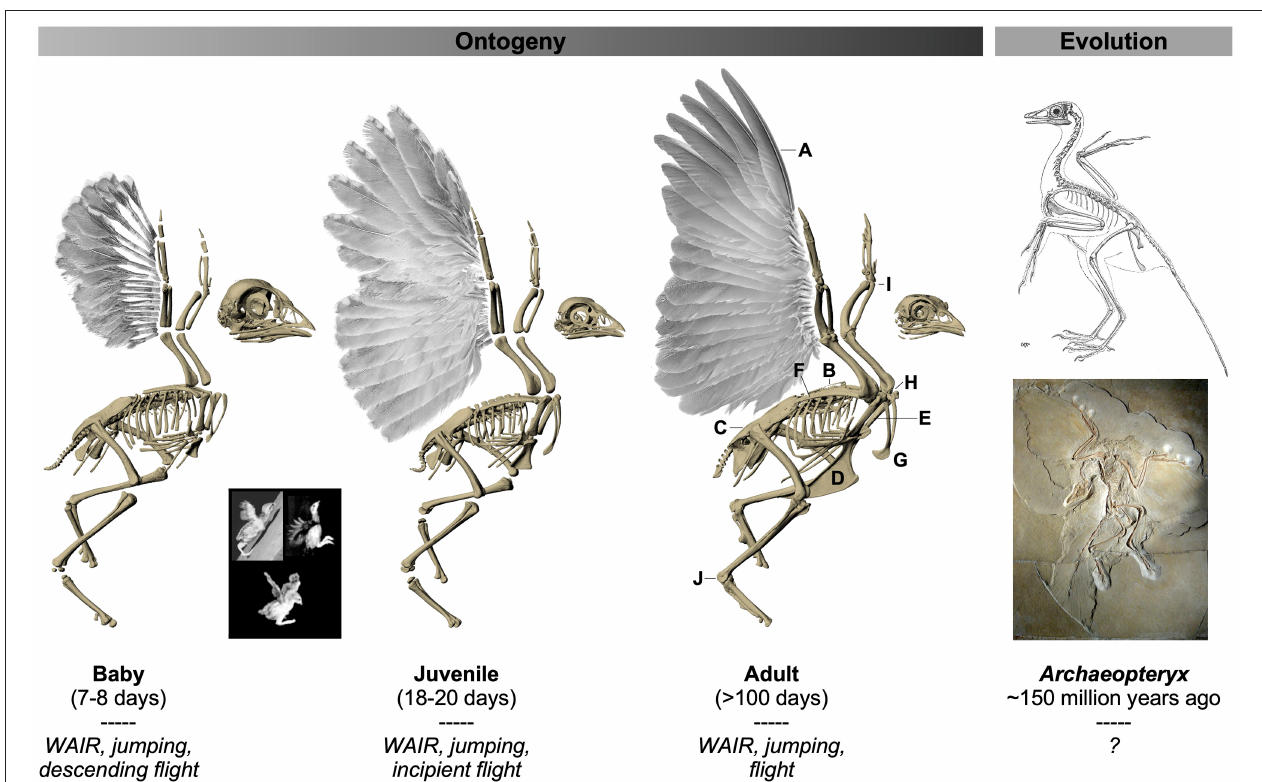
FIGURE 1 | Ontogeny and evolution of the avian flight apparatus. Flight-capable adult birds are characterized by a suite of anatomical features that presumably are adaptations or exaptations for flight. Some of these structures are functionally intuitive, whereas others have no known or demonstrated function(s) but are considered aptations based on their presence in flight-capable birds and their absence in flightless birds and extinct theropods. (A) Stiff, cohesive, and asymmetrical (primaries only) feathers presumably provide stability and reduce permeability for aerodynamic force production (Norberg, 1985; Muller and Patone, 1998; Nudds and Dyke, 2010; Heers et al., 2011; Dial et al., 2012 ). Fused vertebrae are thought to stabilize the trunk while transferring wing- or leg-generated forces to the body (notarium, B ), and/or absorb shock (synsacrum, C ) ( Ostrom, 1976, 1979; Bock, 1986; Kisia, 2011). A robust flight apparatus [e.g., keeled sternum (D) , long and firmly-articulated coracoids (E) , long scapulae (F) , furcula (G) ] permits the attachment and contraction of large, powerful muscles (e.g., pectoralis, supracoracoideus) ( George and Berger, 1966; Ostrom, 1974, 1976, 1979, 1986; Bock, 1986), while the triosseal canal (H) (not visible, but present in all age classes shown) allows the supracoracoideus muscle to function similarly to a pulley and elevate and rotate the wing during upstroke (Walker, 1972; Ostrom, 1976, 1979; Rayner, 1988; Norberg, 1990; Poore et al., 1997; Ostrom et al., 1999 ). Reduced and fused elements in the distal limbs, coupled with channelized joints (I,J) , likely reduce weight and facilitate swift limb oscillation, help coordinate joint movements, and restrict joint motion to keep the wing in a planar orientation during downstroke, or the ankle confined to movements in the direction of motion ( Ostrom, 1974, 1976, 1979; Coombs, 1978; Vazquez, 1992). Unlike adult birds, developing birds and early winged dinosaurs like Archaeopteryx lack many of these flight aptations: their wings are smaller and/or less aerodynamically effective, and their skeletons are more gracile and less constrained ( Heers et al., 2011, 2014; Heers and Dial, 2012). Immature birds nevertheless recruit their rudimentary wings during a variety of locomotor behaviors [italicized text, and inset: wing-assisted incline running, i.e., WAIR (top left); wing-assisted jumping (top right), varying degrees of flight (bottom)], and achieve flight capacity long before flight aptations are fully acquired (Dial, 2003; Dial et al., 2008, 2015; Dial and Carrier, 2012; Heers and Dial, 2015; Heers et al., 2016). Images of Chukar Partridges modified, with permission, from Heers and Dial (2012) and Heers et al. (2018); images of Archaeopteryx (top: by Gerhard Heilmann (Heilmann, 1926); bottom: by H. Raab, licensed under CC BY-SA 3.0) in public domain. Not to scale. wings used for WAIR, jumping, and incipient flight; > 100